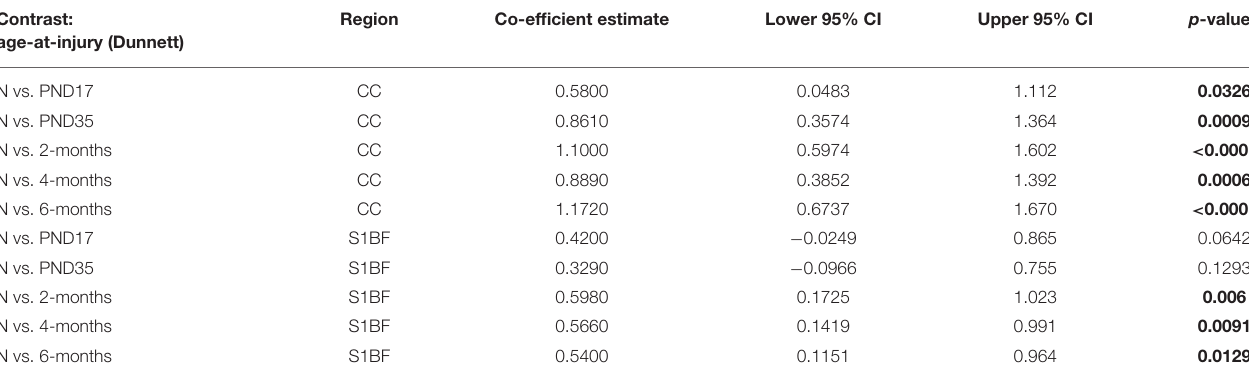
TABLE 3 | SMI32 post-hoc contrasts between age-at-injury groups and naïve controls, separated by region, using the Dunnett’s procedure. Contrast: Region Co-efficient estimate Lower 95% CI Upper 95% CI p age-at-injury (Dunnett)